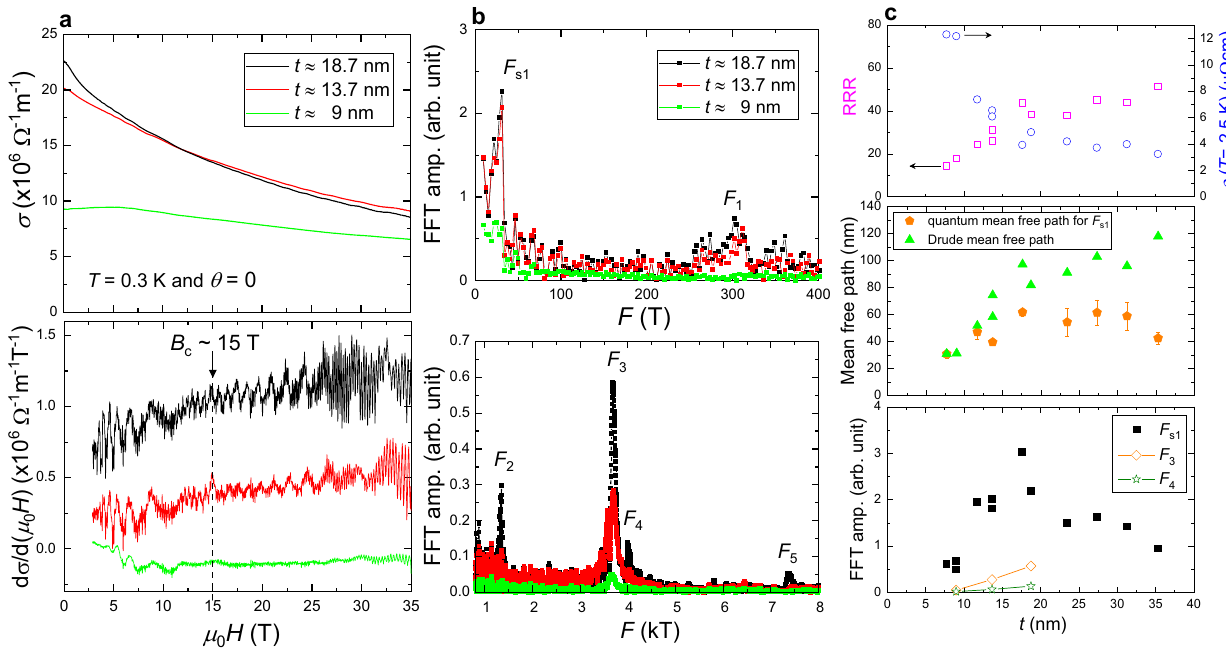
Fig. 3 The thickness dependence of quantum oscillations in SRO fi lms. The upper panel of a shows the fi eld dependent σ with fi elds up to 35 T for three SRO fi lms with different t values, and the corresponding d σ /d( μ 0 H ) versus μ 0 H were plotted in the lower panel, where pronounced quantum oscillations were observed for μ 0 H ≥ 3.5 T. The upper panel and lower panel of b show the FFT spectra in the low- frequency region and high-frequency region, respectively. The quantum oscillation for F s1 (about 30 T) dominates in the low fi eld region, and it seems to vanish for μ 0 H ≥ 15 T. Other frequencies of F 1 – F 5 appears when μ 0 H ≥ 12 T. c A summary of the thickness dependence of extracted mean free path and FFT amplitudes are shown in the middle-panel and lower-panel, respectively. The uncertainty in the quantum means free path came from the standard deviation in the fi tting to the damping term. The nonmonotonic variation of the FFT amplitude for F s1 with t is in big contrast to the nearly t -linear dependence for F 3 and F 4 . The corresponding RRR and ρ (2.5 K) as a function of t were plotted in the upper panel of ( c